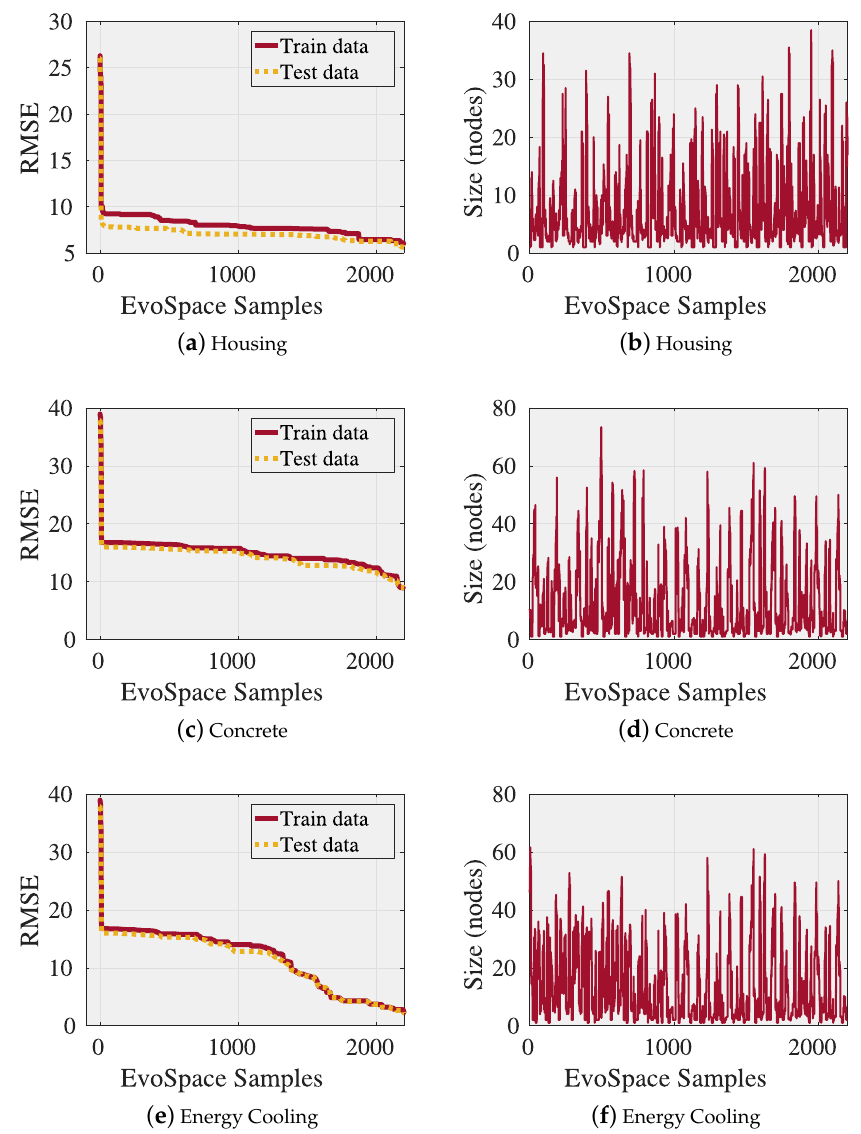
Figure 7. Performance of a single run of the PEA implementation of neat-GP-LS in EvoSpace for: Housing ( a ), ( d ); Concrete ( b ), ( e ); and Energy Cooling ( d ), ( f ). The plots in the left column show the evolution of the training and testing RMSE. The plots in the right column show the evolution of the average program size. All plots are ordered based on the number of samples taken from the